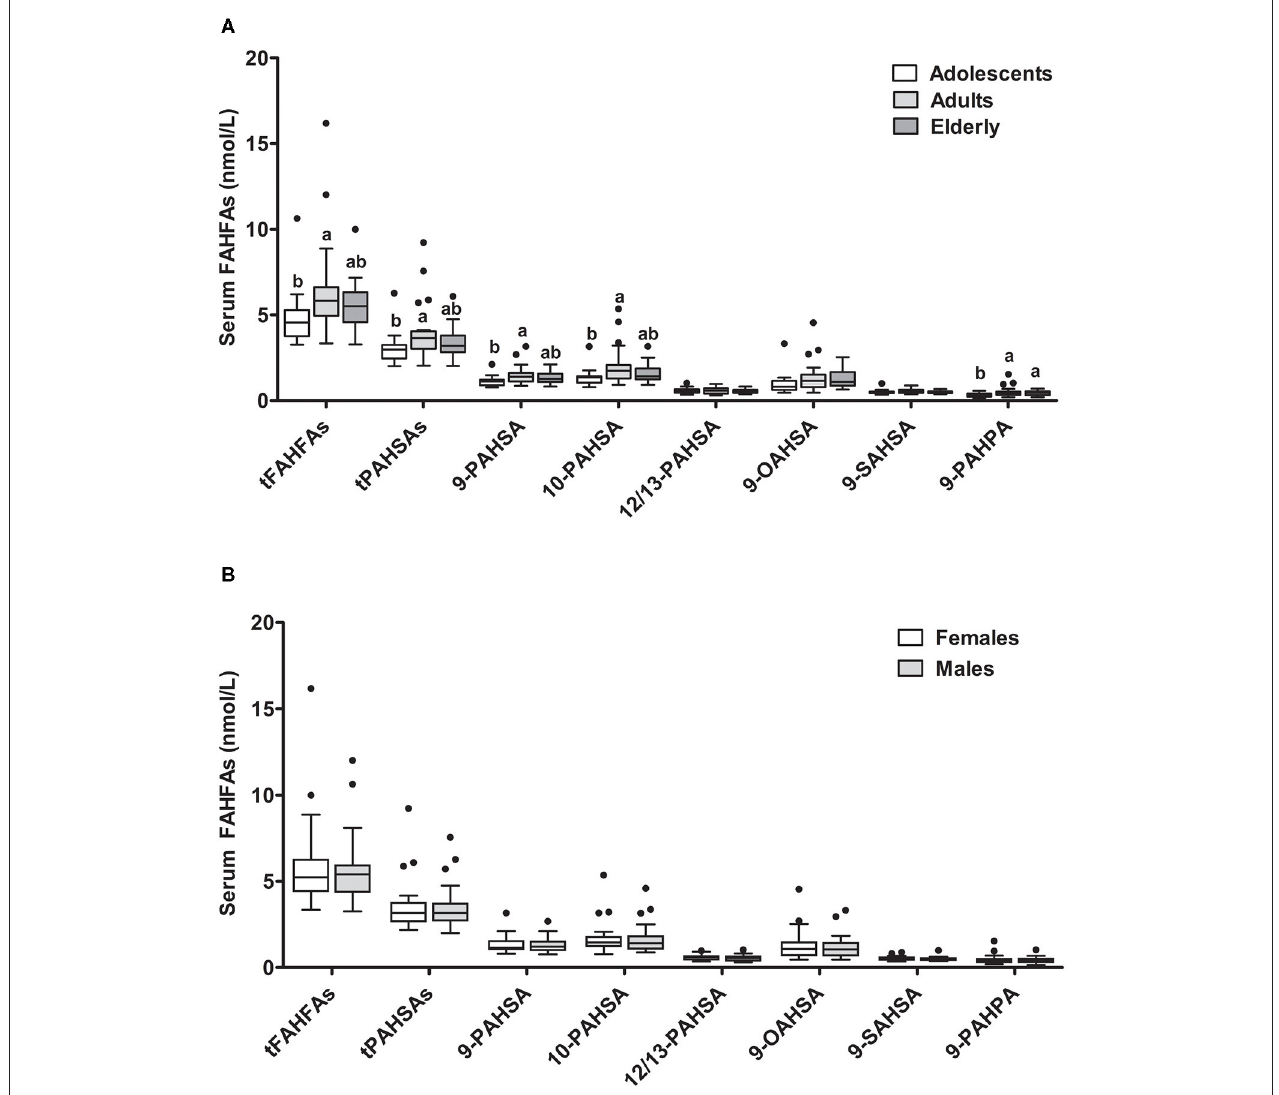
FIGURE 1 | FAHFA concentrations in different age groups and sexes. Serum FAHFA levels were measured in the enable cohort according to age (A) and sex (B) . Adolescents, 18–25 years; Adults, 40–65 years; Elderly, 75–85 years. Kruskal-Wallis test with Dunn’s posttest was used to compare the age groups. Mann-Whitney test was used to compare females and males. Box plots describe the median and the 25th percentile and 75th percentile. n = 20 per age group and n = 30 per sex. Labeled medians without a common superscript letter differ, P < 0.05. t, total (sum of FAHFAs/PAHSAs measured); FAHFA, fatty acid esters of hydroxy fatty acid; OAHSA, oleic acid-hydroxy stearic acid; PAHPA, palmitic acid-hydroxy palmitic acid; PAHSA, palmitic acid-hydroxy stearic acid; SAHSA, stearic acid-hydroxy stearic